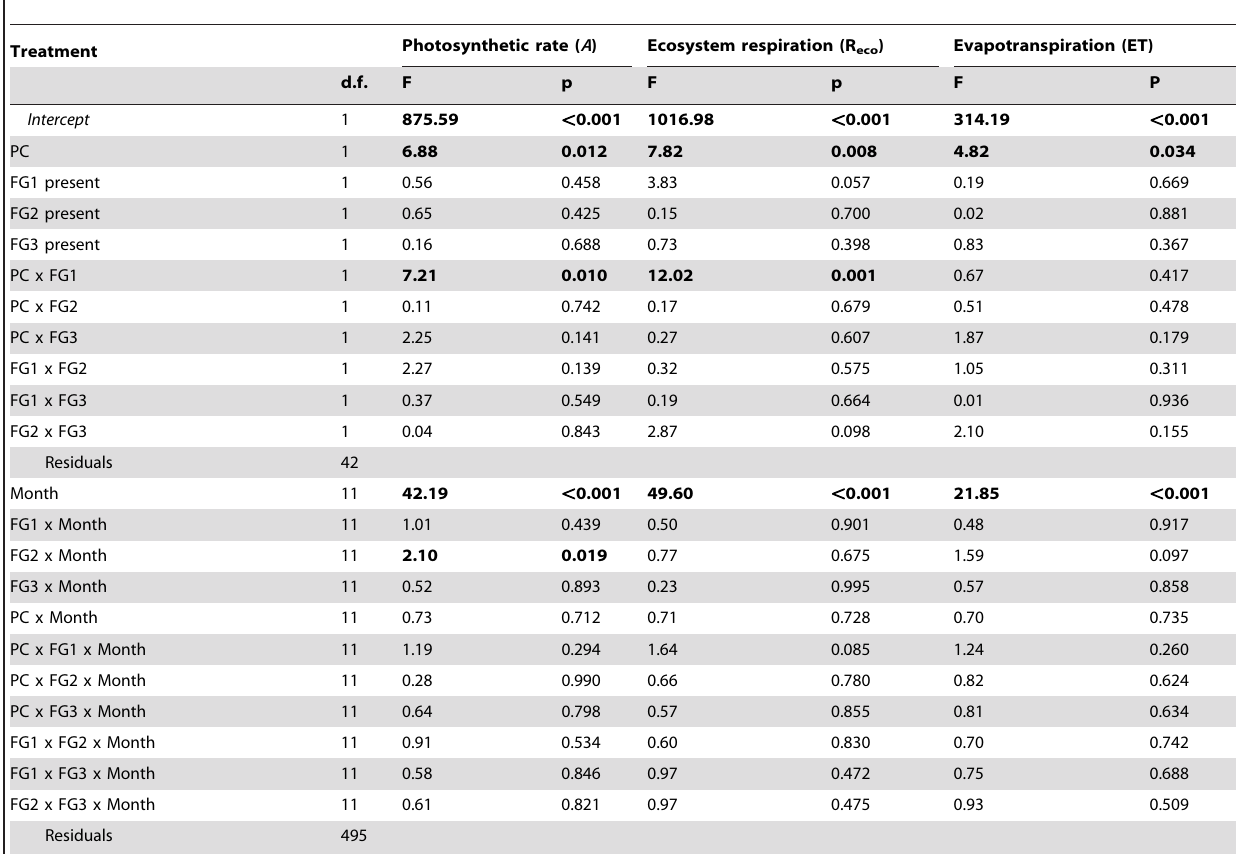
Table 5. Results of linear mixed effects models, testing precipitation change (PC) and functional group(FG) treatment effects upon carbon and water fluxes.